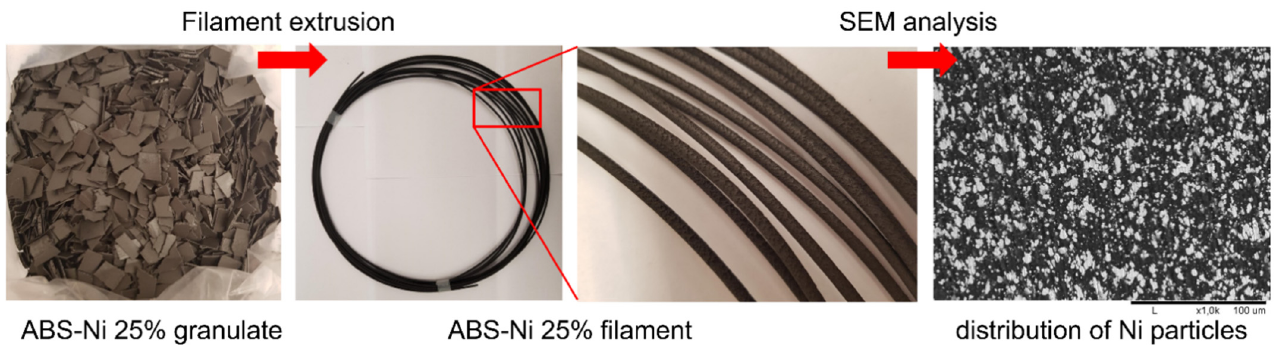
Figure 5. ABS-Ni 25% composite granulate and obtained filament. SEM image of the cross-section of the filament showing the distribution of nickel particles in the polymer matrix.